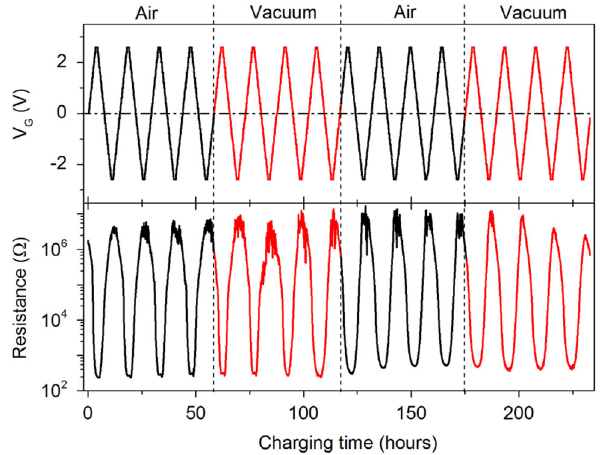
Fig. 4 Sample resistance measured as a function of charging time as the sample is charged and discharged in air and in vacuum. Top, the changes of the gate voltage ( V G ) as a function of charging time. The electrolyte is PEG-NaF and the charging temperature is T = 304 K. The voltage was changed in steps of 0.2 V and the charging time for each step is 15 min. When V G increases from − 2 V to 2 V, the sample is charged and when V G drops from 2 V to − 2 V the sample is discharged. For the black curves, the charging/discharging process occurs in air and for the red curves, the sample was charged/ discharged in a vacuum of 10 − 6 Torr. Bottom, sample resistance measured as V G was cycled. The charging and discharging processes are very reversible and reproducible, and it apparently makes no difference whether the environment is air or